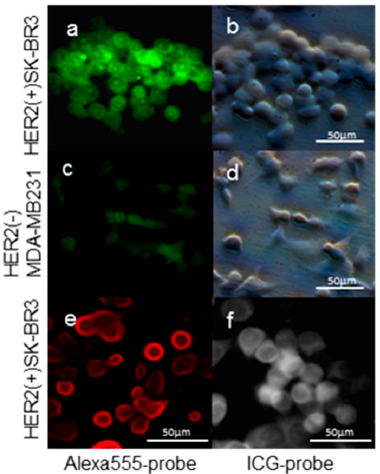
Figure 2. Fluorescence image of human epidermal growth factor receptor 2 (HER2)-targeted PCSNs. SK-BR3 cells ( a , b ) exhibited stronger fluorescent signals of Alexa488 than MDA-MB231 cells ( c , d ) as demonstrated by the addition of dye-conjugated HER2 targeted PCSNs to the conditioned medium. Alexa 555-probe in SK-BR3 cells ( e ); and indocyanine green (ICG)-probe in SK-BR3 cells ( f ).